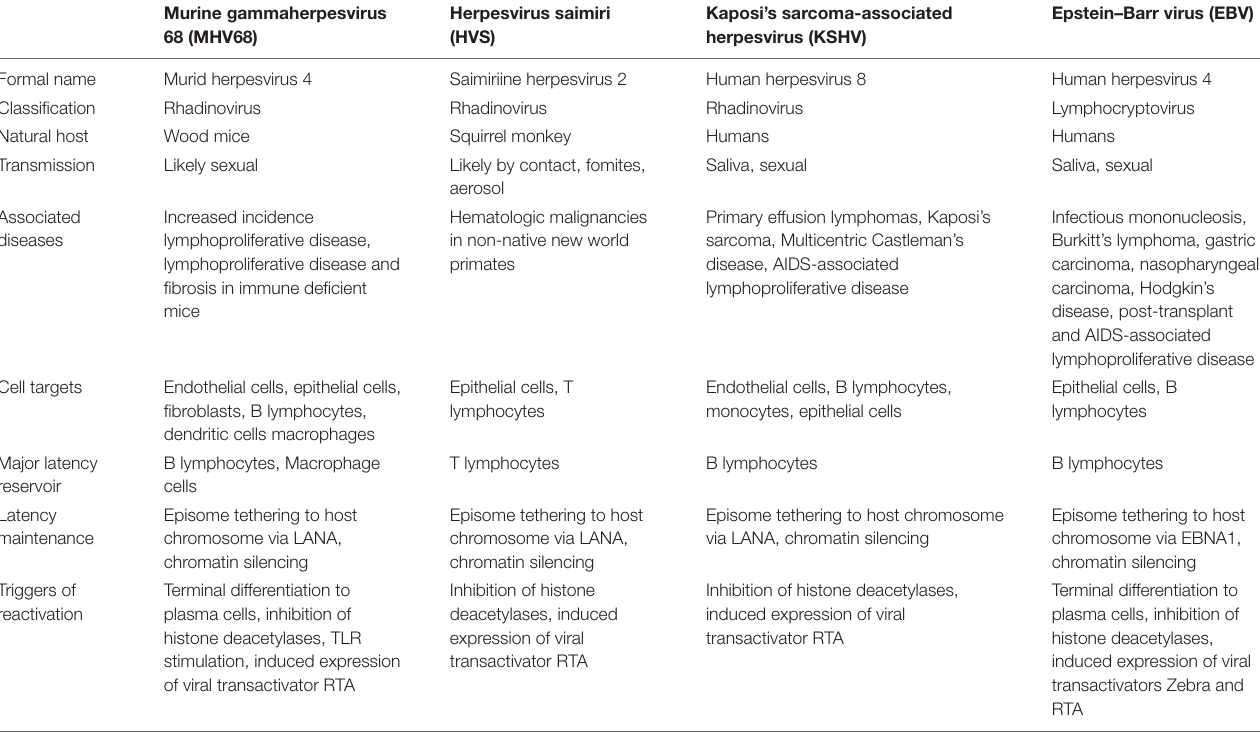
TABLE 1 | Comparison of select